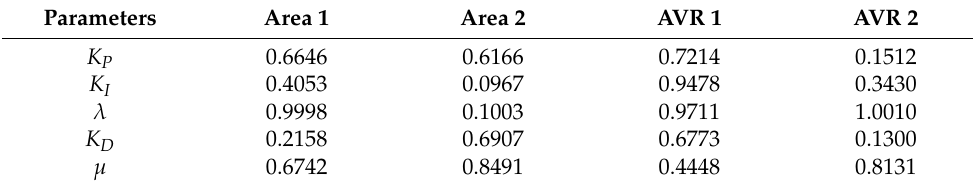
Table 7. FOPID controller gain for RLD, variable solar irradiations, and irregular wind power.